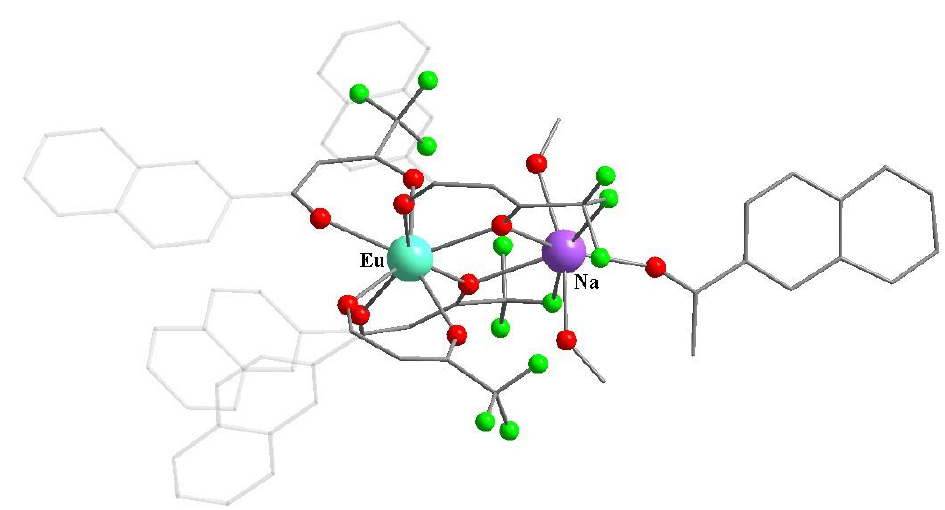
Figure 15. Molecular structure of 32 [83]. Hydrogen atoms have been omitted, some ligands groups are transparent for clarity. The cif has been retrieved from CCDC. CCDC number is 2071833. Succinimide can replace one of the water molecules from the coordination environment of alkali metal ions, thereby acting as coligand in heterometallic complex 33 (Figure 16) [85]. Tetrakis - β -diketonate [Eu-Na] ( 33 ) based on tta exhibited the high phosphorescence quantum yield of 71% and the afterglow time of 0.84 ms upon excitation at a wavelength of 365 nm.